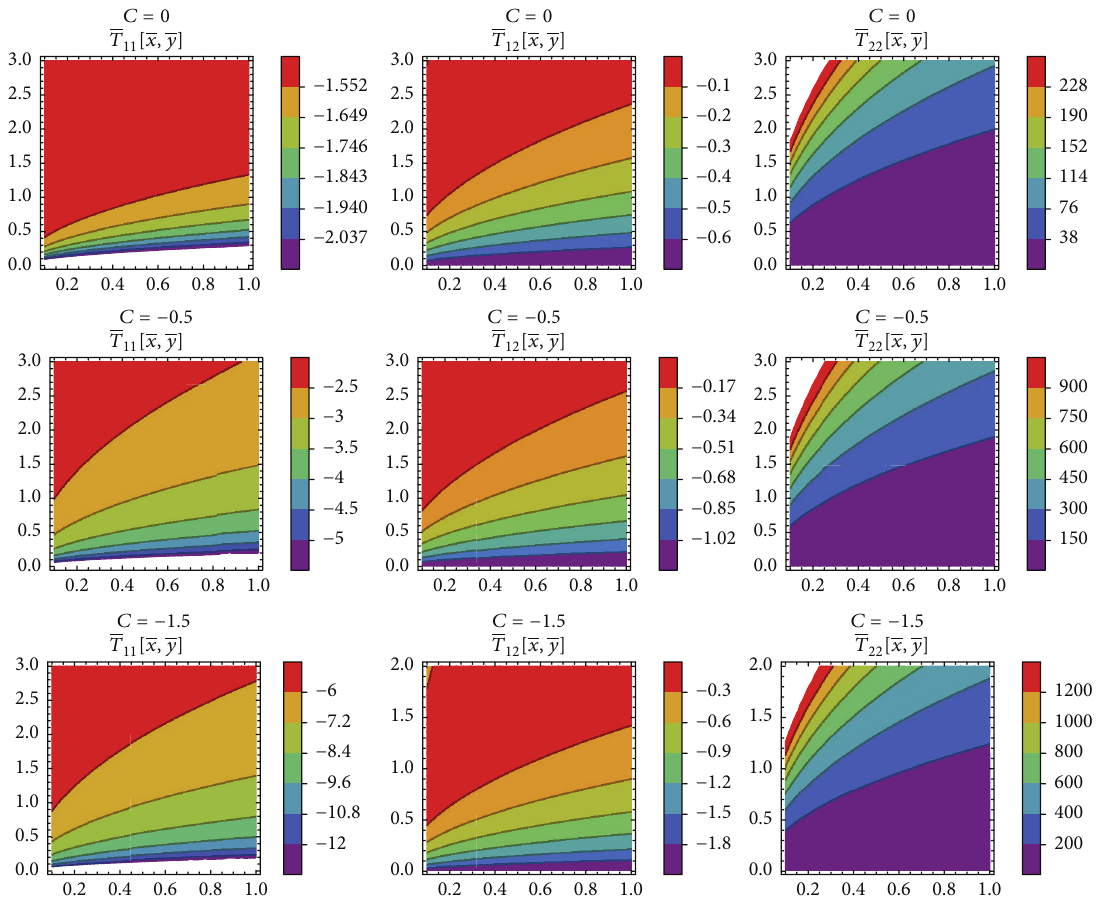
Figure 4: Scaled stress components in 𝑥 - 𝑦 plane for values of 𝐶 = 0, −0.5, −1.5